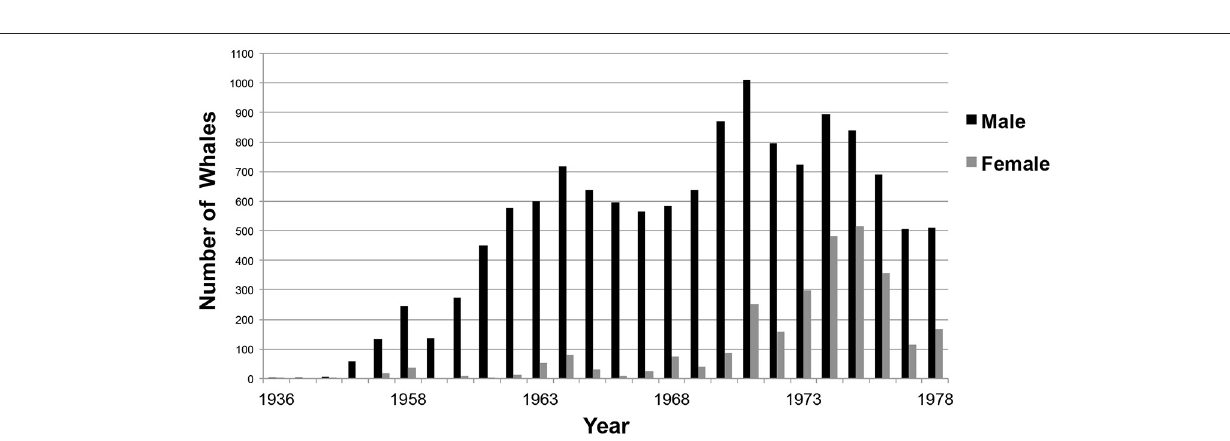
FIGURE 8 | Number of sperm whales by gender taken each year during commercial whaling operations off Western Australia. ( n = 16,080; Source: